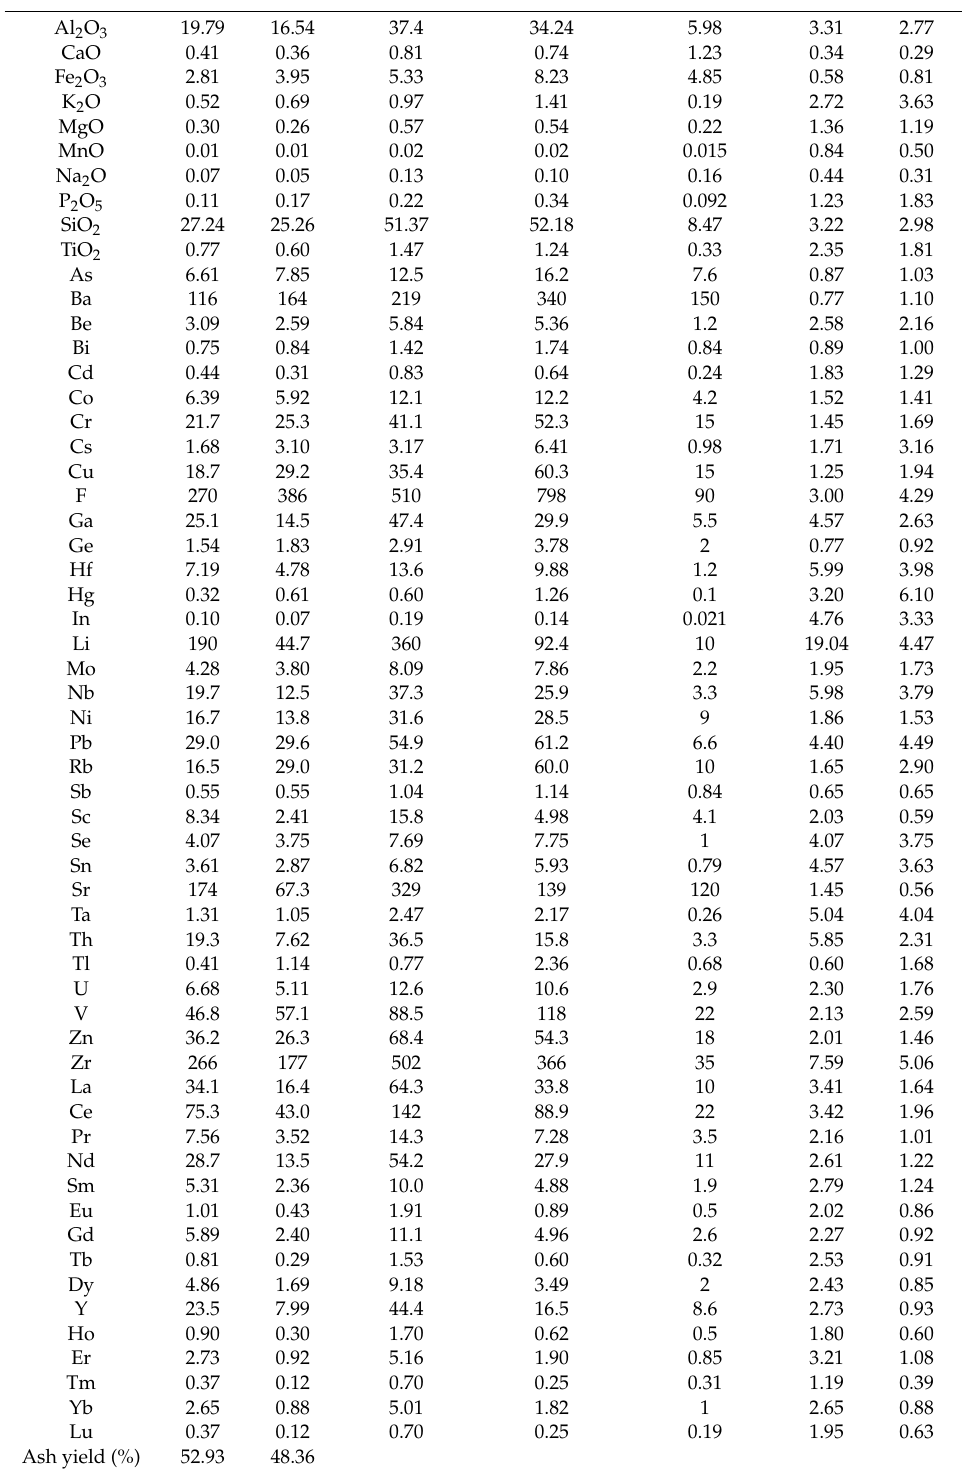
Table 3. Average concentrations of major (%) and trace ( µ g / g) elements in the feed coals from the Xilaifeng and Damo power plants.